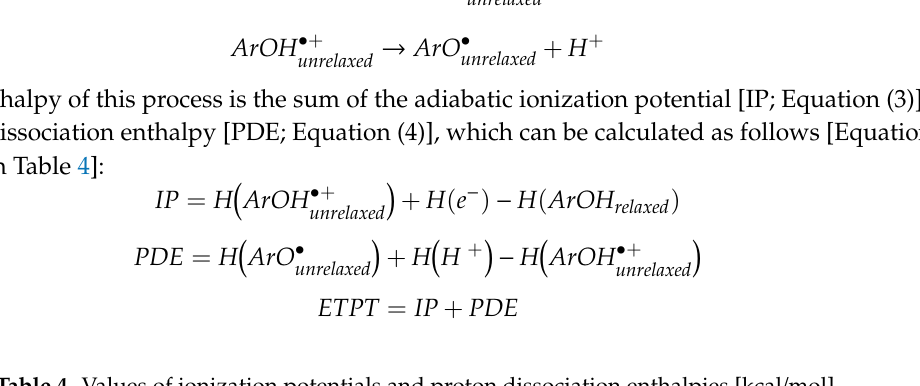
Table 4. Values of ionization potentials and proton dissociation enthalpies [kcal / mol].